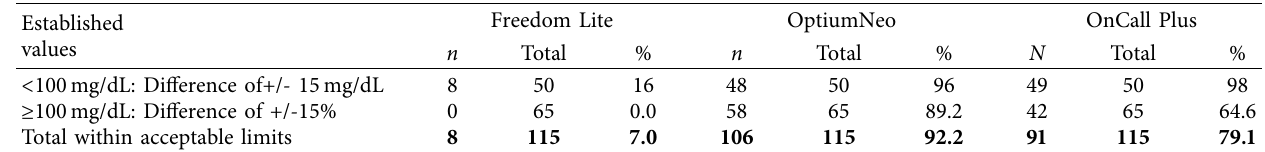
Table 5: Percentage and absolute values of blood glucose concentration obtained using the three glucometers, according to ISO 15197 :2013 standards in dogs.